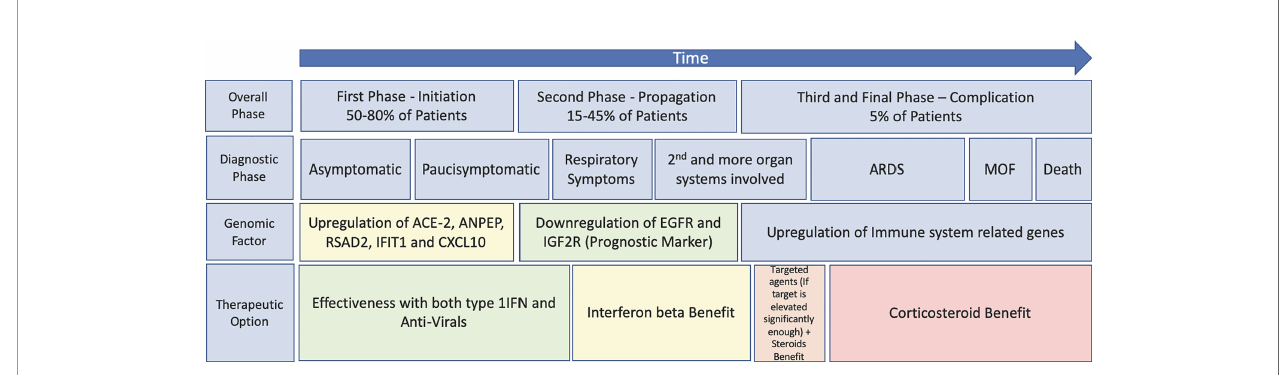
FIGURE 1 | Schematic highlighting of the progression of SARS-CoV-2 and COVID using both Turk et al. ’ s three clinico-biological phases (21) and Feuillet et al. ’ s disease kinetic model for an outlook of the bene fi ts of previously trialled therapeutics (6) (plotted against the disease course). MOF, multiple organ